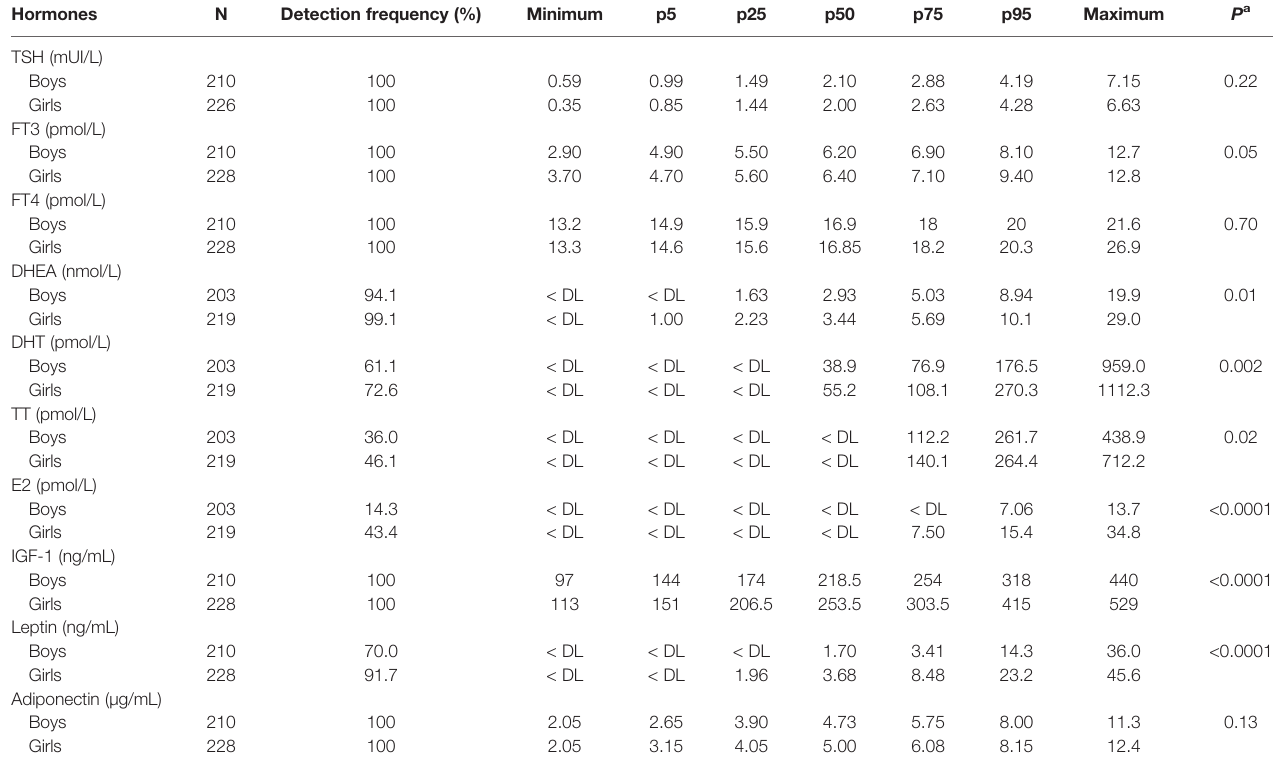
TABLE 3 | Detection and concentrations of hormones in child blood samples according to sex. Hormones N Detection frequency (%)